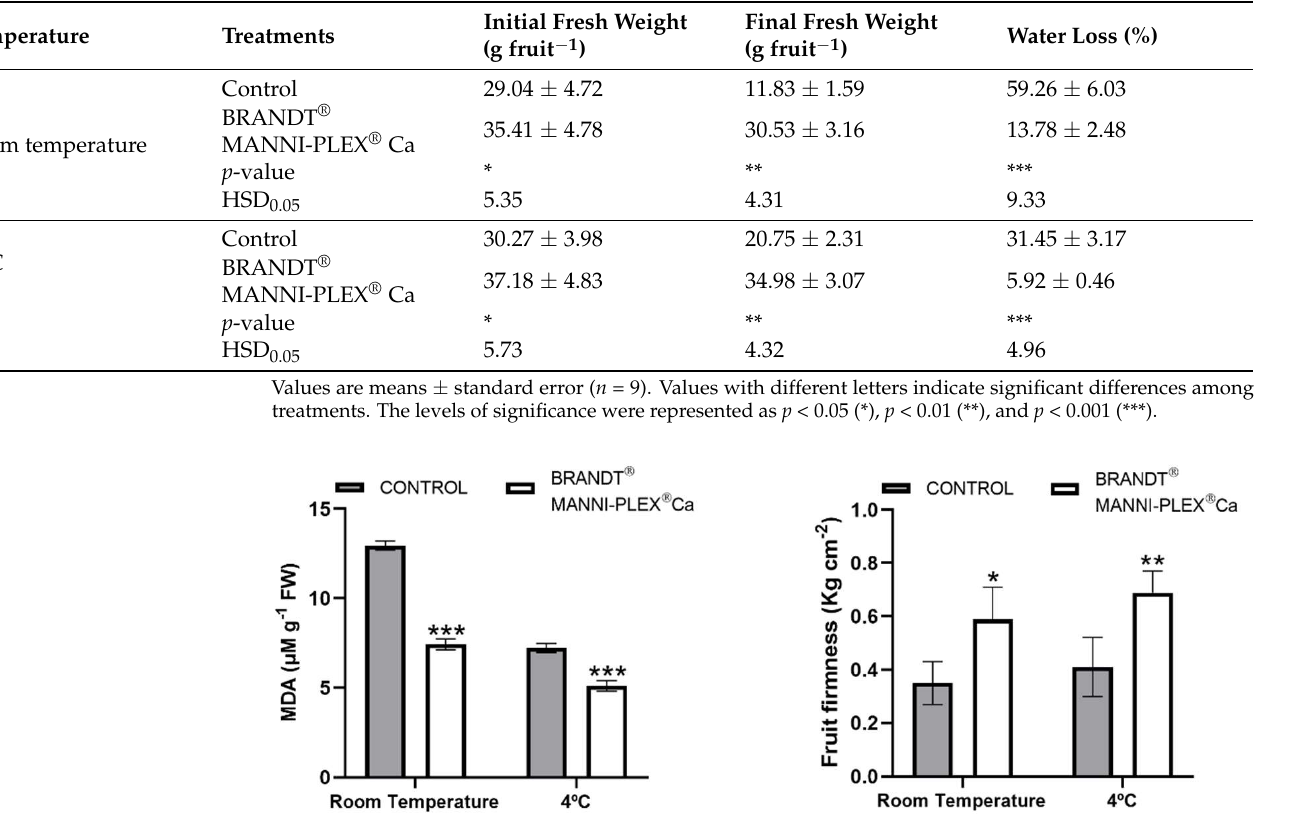
Table 4. Effect of BRANDT ® MANNI-PLEX ® Ca application on the initial and final fresh weight and water loss percentage in pepper fruits subjected to post-harvest at room temperature and 4 °C.